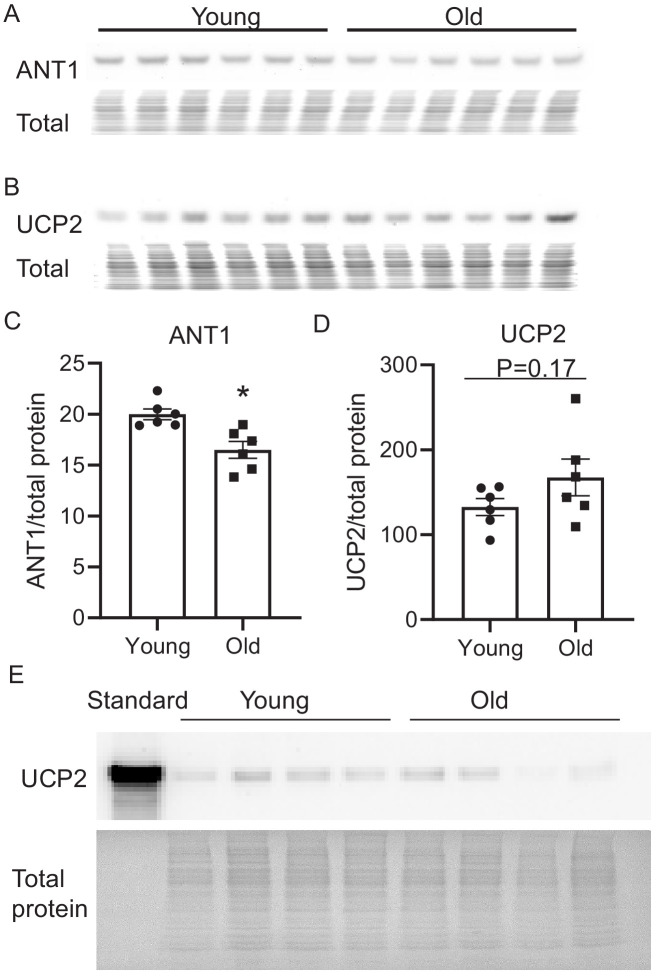
Aging effect on ANT1 and UCP2 cardiac protein abundance.Aging slightly, but significantly decreases ANT1 levels in the mouse heart. Western blot of ANT1 (A, C) and UCP2 (B, D). N = 6 mice in each group. Student’s t-test was applied to determine the statistical significance. *p<0.05 vs young. The total protein loading control was stained with MemCode Reversible Protein Stain Kit for Polyvinylidene difluoride Membranes (Pierce, Rockford, IL). The identity of the band as UCP2 in B was confirmed using a recombinant UCP2 protein standard (Origene, CAT#: TP761109), as shown in E.